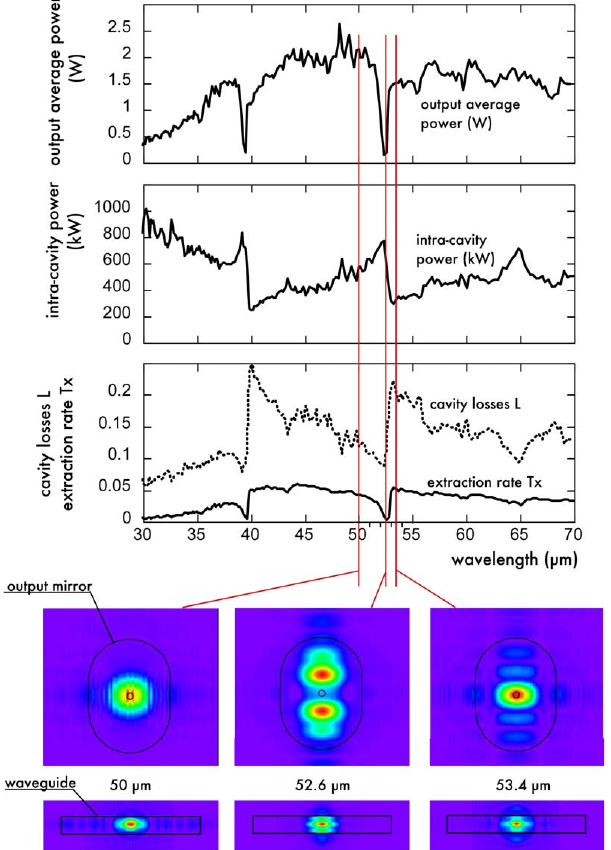
FIG. 11. (Color) Simulation for FELIX, with mode profiles on the output mirror and at the waveguide entrance, close to (cid:2) ¼ 50 (cid:1) m